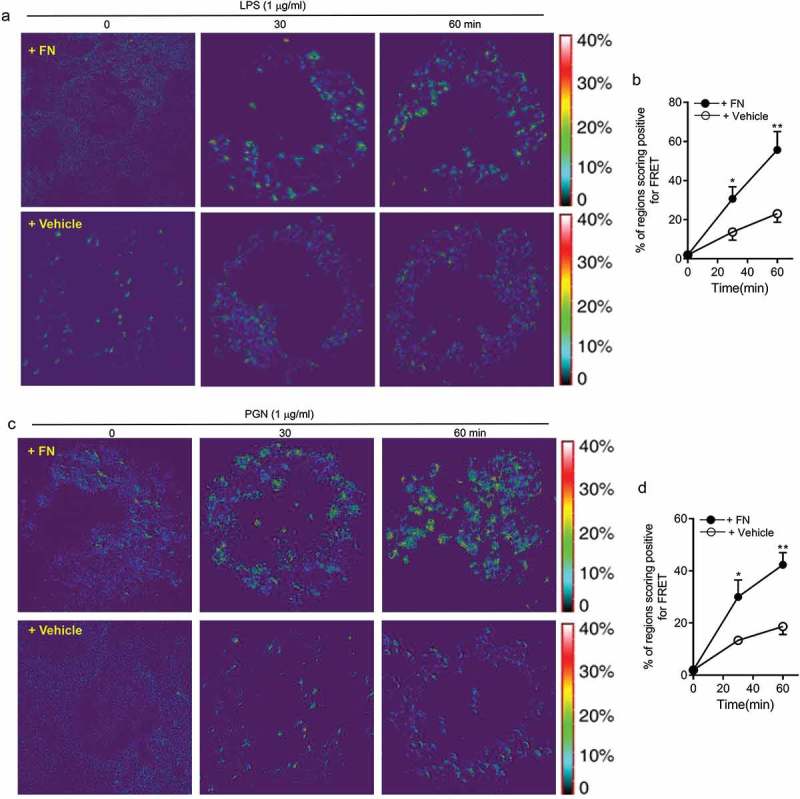
FN significantly promotes innate immune responses of macrophages through interaction of FN-integrin β1 signal and TLR2/TLR4 signal. FRET assay measuring the access of an integrin β1-associated donor fluor AF488 or FITC-TLR4 or TLR2-localized with fluor AF594 or PE-integrin β1 was used to quantify the association of TLR4 or TLR2 and integrin β1 following LPS (a and b) or PGN (c and d) with or without FN. After stimulation of LPS or PGN for 0 min and a chase of 30, 60 min at 37°C, FRET was measured by laser confocal microscopy using the FRET Acceptor Bleaching program, which verifies the donor molecule’s loss of intensity when in close proximity to an acceptor molecule, before and after selective bleaching of the acceptor. Representative images from FRET assay showing the association of AF488-labeled TLR4 Ab or TLR2Ab with AF594-labeled integrin β1 Ab in peritoneal macrophages (a and c). Comparison of the percentage of FRET-positive regions and FRET efficiency between integrin β1 and TLR4 or TLR2 with fibronectin or without in peritoneal macrophages (b and d). The energy transfer efficiency was quantified, as described in Materials and Methods. The percentages of FRET-positive regions were quantified by randomly counting over 10–15 areas within one cell and counting > 10 cells in each tested group in three or more independent experiments. Data are mean ± SE from triplicate samples and are representative of three independent experiments. ∗ p < 0.01; ∗∗, p < 0.05. Statistical comparisons among treatment groups were performed by randomized-design two-way ANOVA and followed by unpaired Student’s t-test for two groups using Prism software (Graph Pad Inc., La Jolla, CA). Statistical significance was defined as a * P value of less than 0.05 and . as a ** P value of less than 0.01.